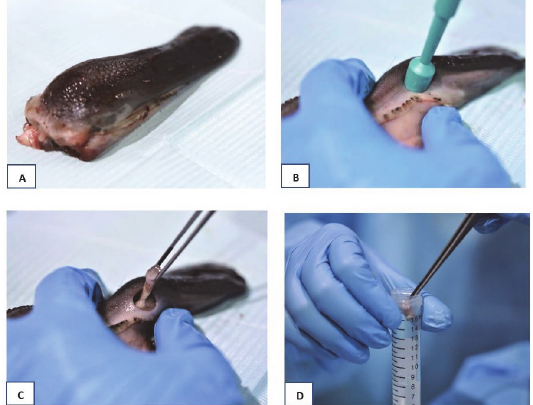
Figure 1. Preparation of tissue samples. ( A ) Goat tongue. ( B , C ) Punch biopsy. ( D ) Samples placed directly in a 15 mL tube containing the fixative solution.